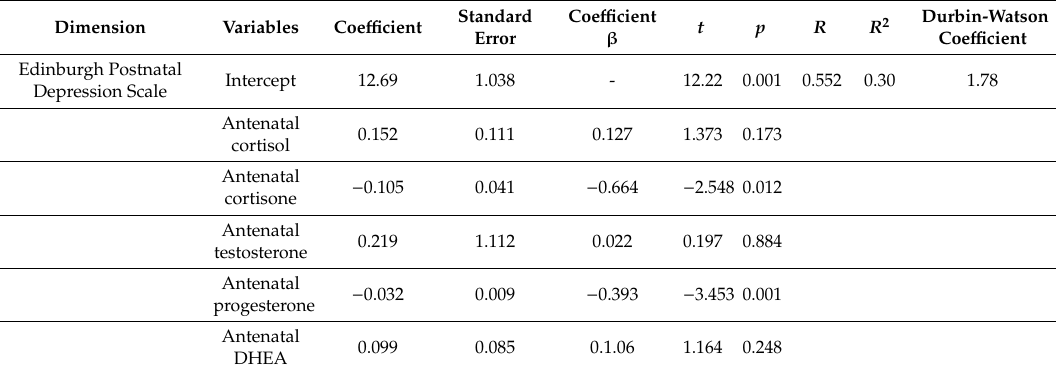
Table 4. Multiple linear regression with post-partum depression scores as dependent variables (Edinburgh Postnatal Depression Scale) and antenatal hair steroid levels (cortisol; cortisone; testosterone; progesterone; DHEA) as predictors.